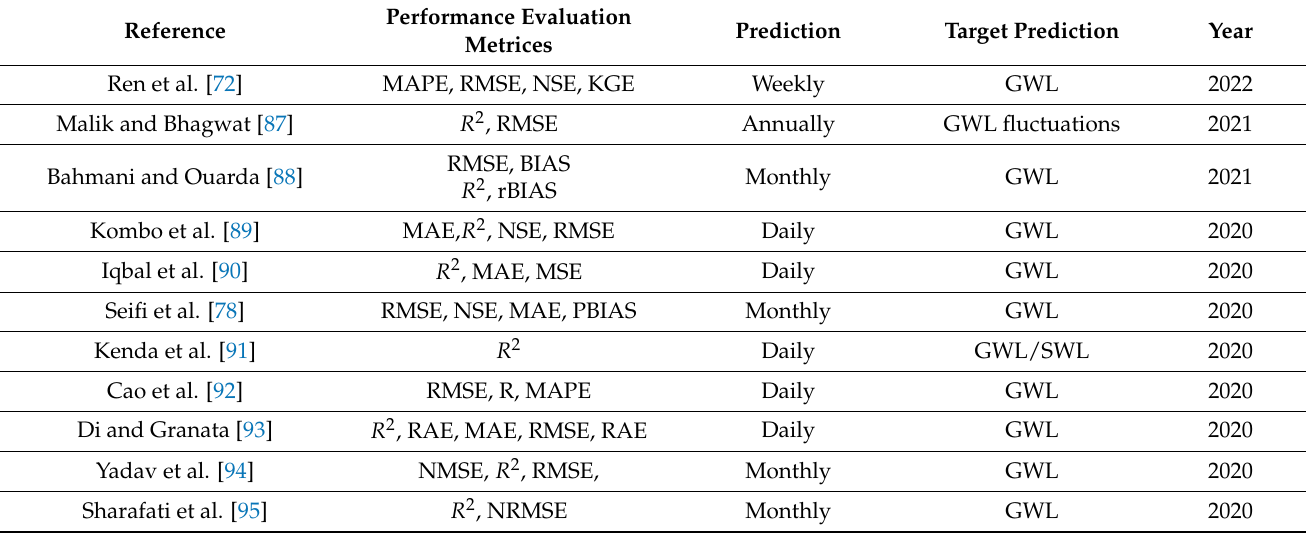
Table 4. Different performance evaluation measures used by different experts for GWL